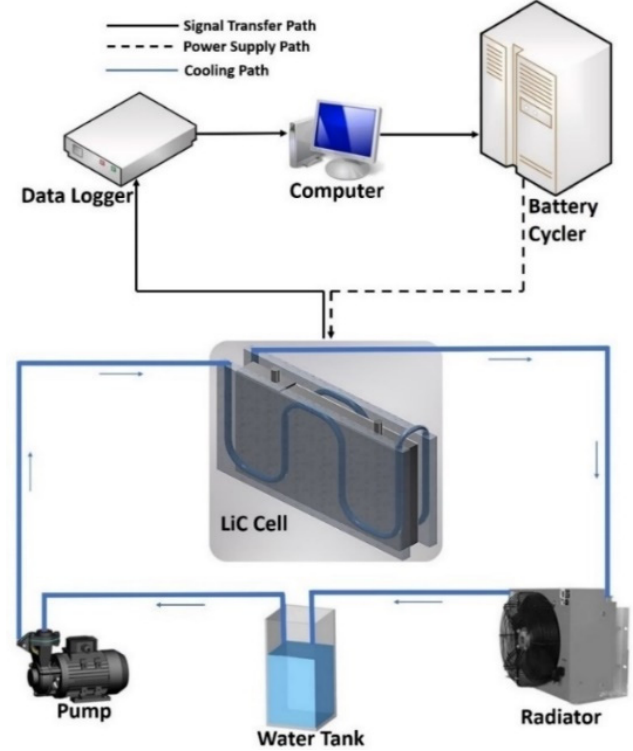
Figure 5. Test setup of the liquid cooling system for LiC cell [27].